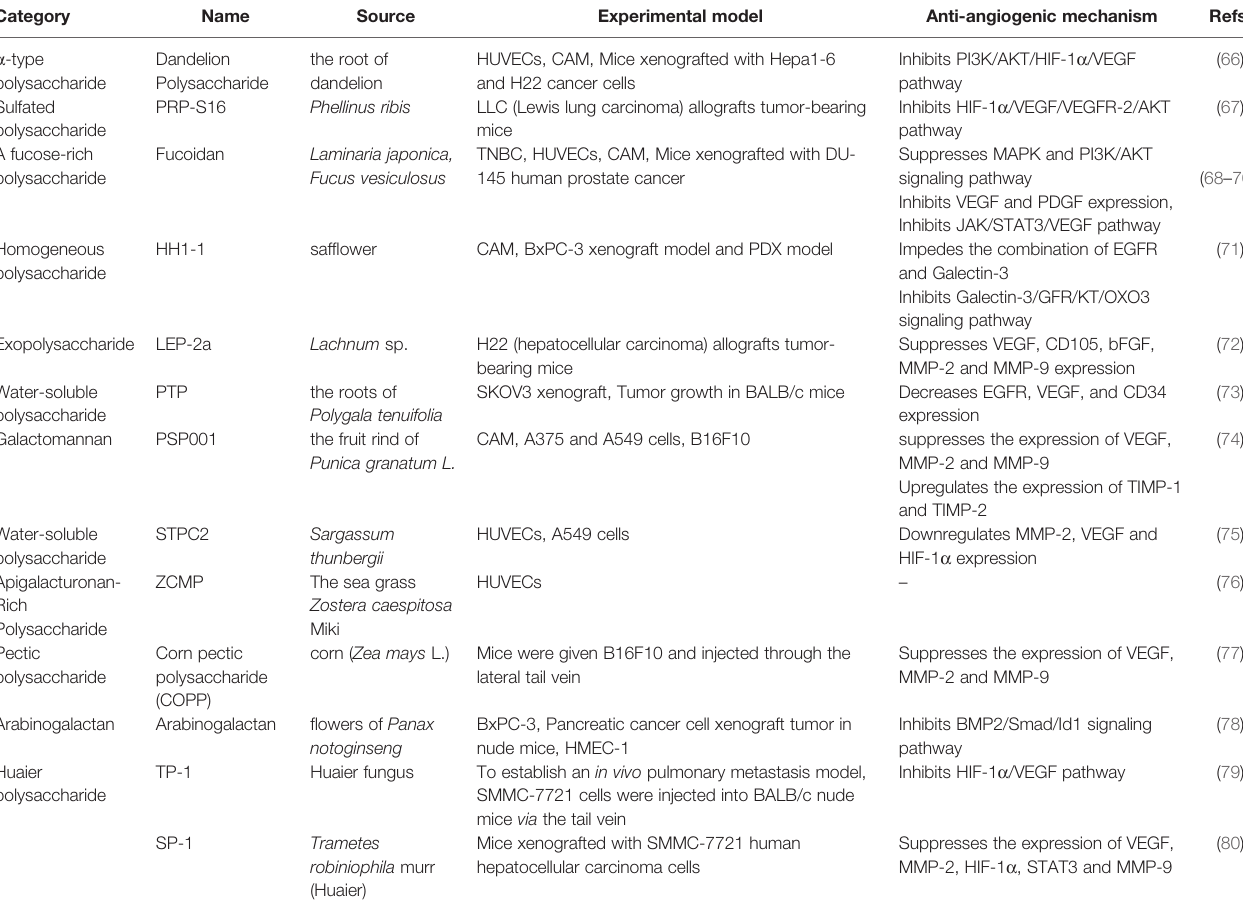
TABLE 3 | Natural anti-tumor angiogenesis polysaccharides and their sources, experimental models and anti-angiogenic mechanisms.